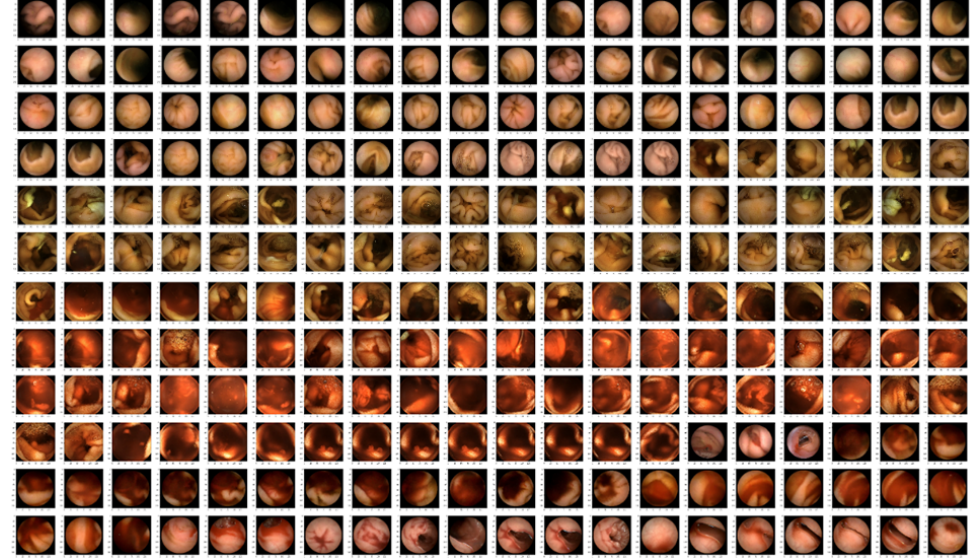
Figure 9. Used image data set. Validation part of the bleeding and non-bleeding